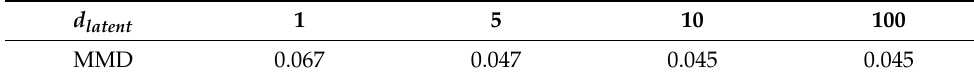
Table 2. Convergence study of the latent space dimension.